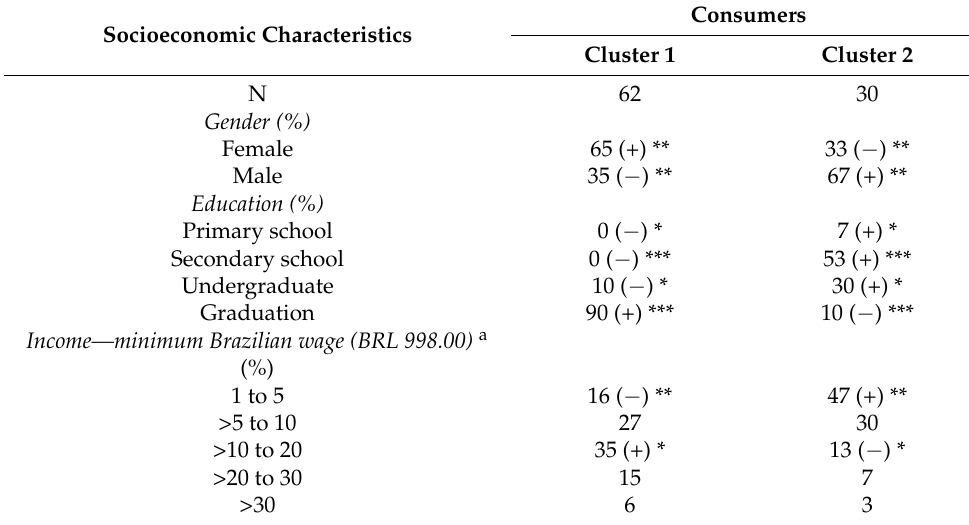
Table 3. Socioeconomic characteristics of consumers from clusters 1 and 2 ( n = 92). Socioeconomic